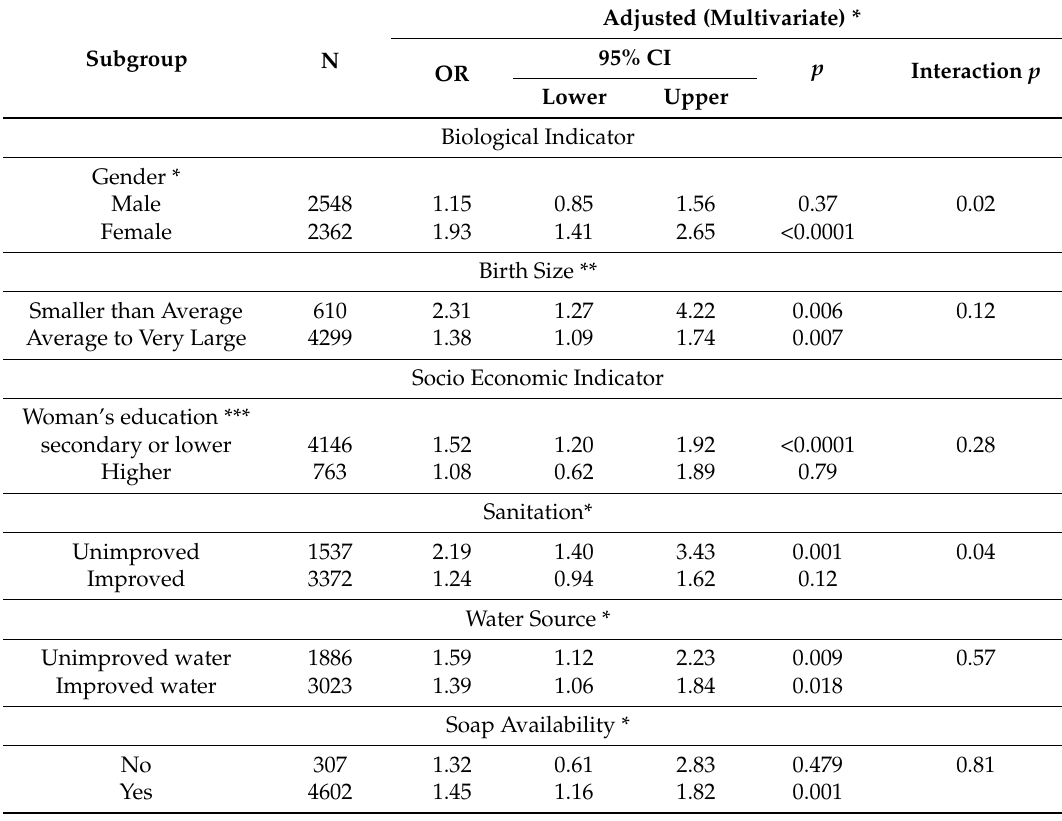
Table 3. Subgroup analysis on association between diarrhea in children aged less than 24 months and disposal of child’s feces by biological indicators, socio economic indicators and WASH indicators. Adjusted (Multivariate) * 95% CI Subgroup N OR